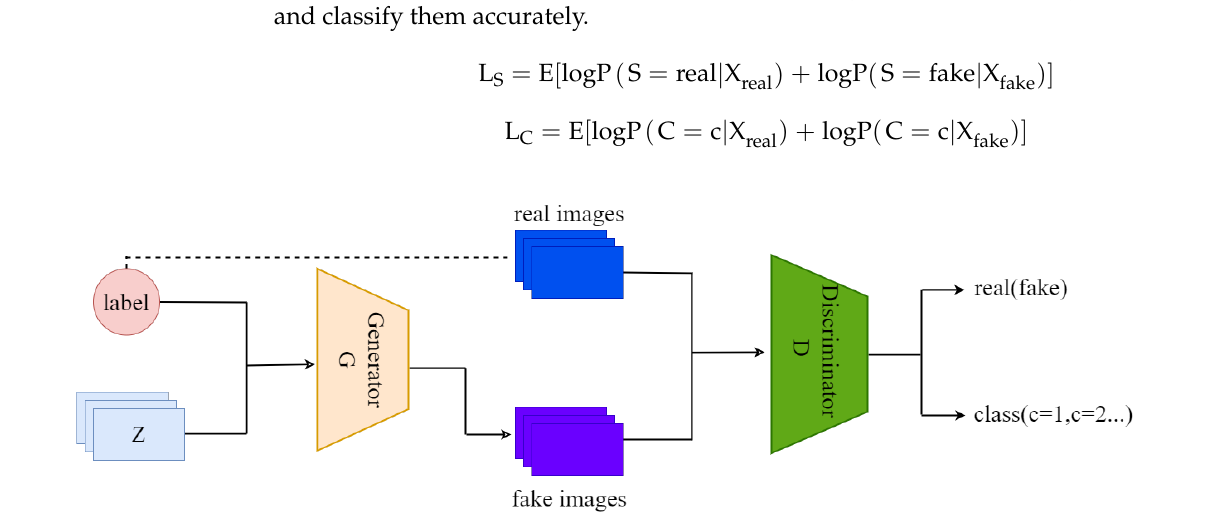
Figure 1. The model framework of conditional image synthesis with auxiliary classifier GANS.